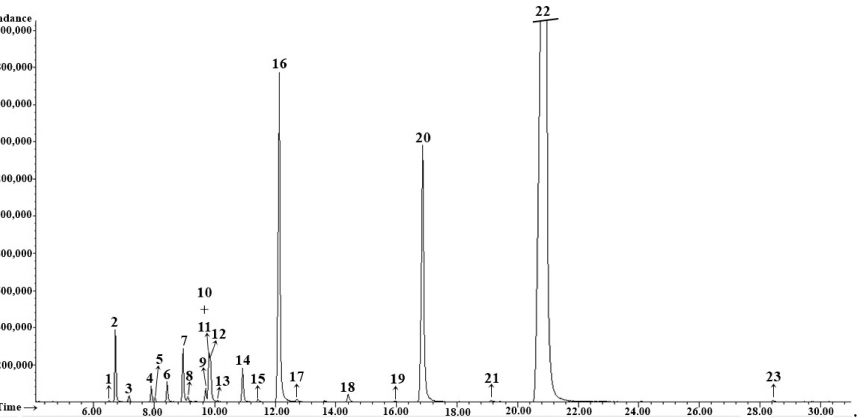
Figure 3. GC/MS chromatogram of essential oil isolated from wild fennel umbels (2nd stage: premature-waxy).